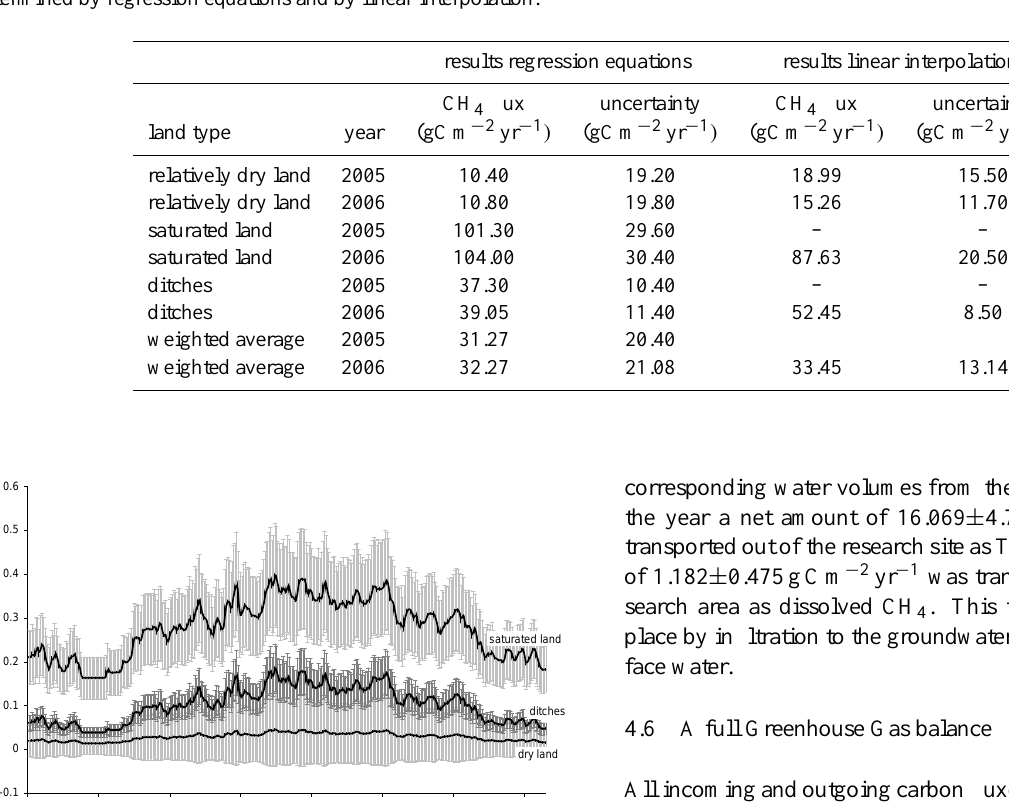
Table 7. Annual totals of CH 4 emission from the relatively dry land, the saturated land and the ditches as well as the weighted average determined by regression equations and by linear interpolation.